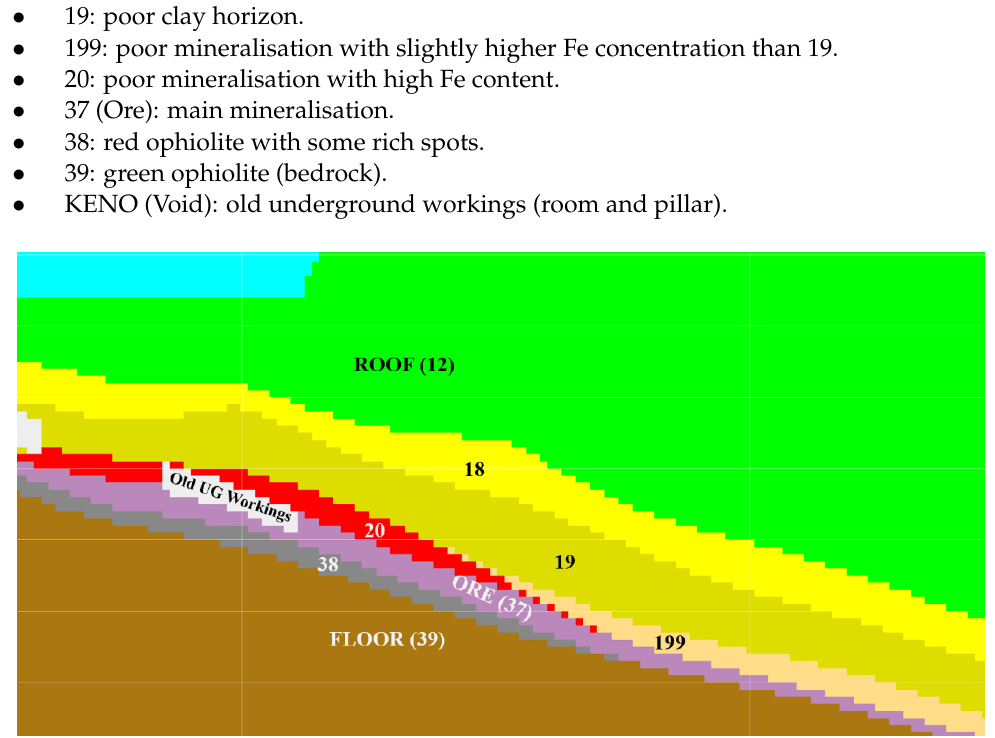
Figure 3. Cross section of Tsouka block model colour-coded using modelled domains.